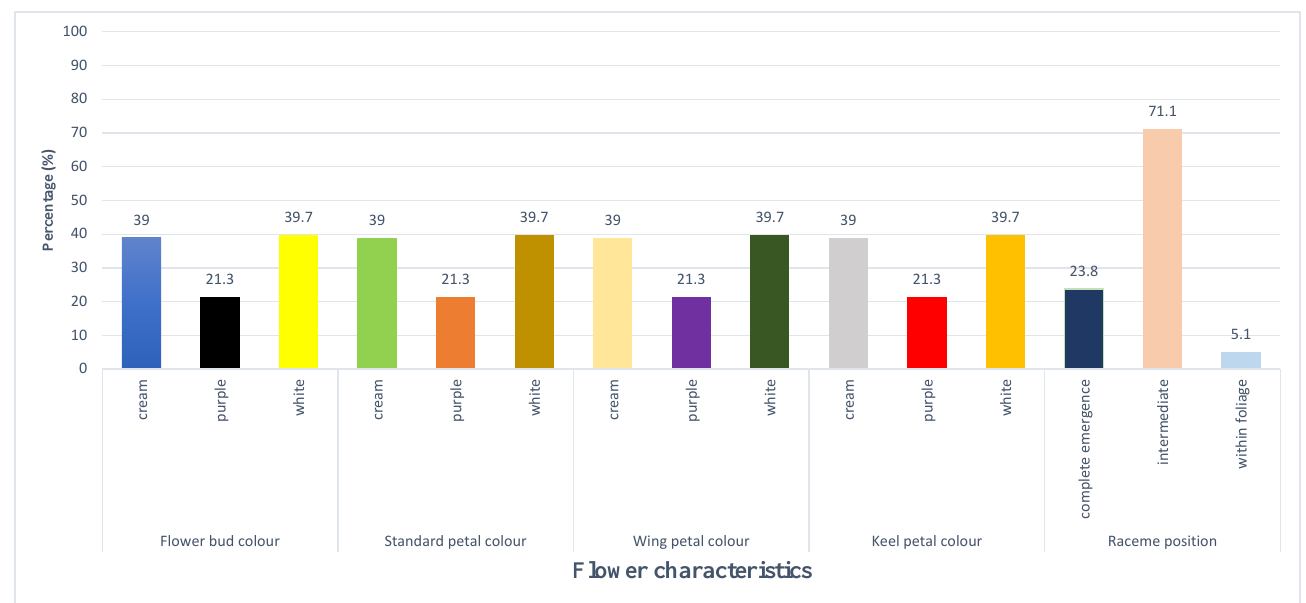
Figure 2. Variations in selected flowering characters of lablab accessions Variation of characters at podding stage.